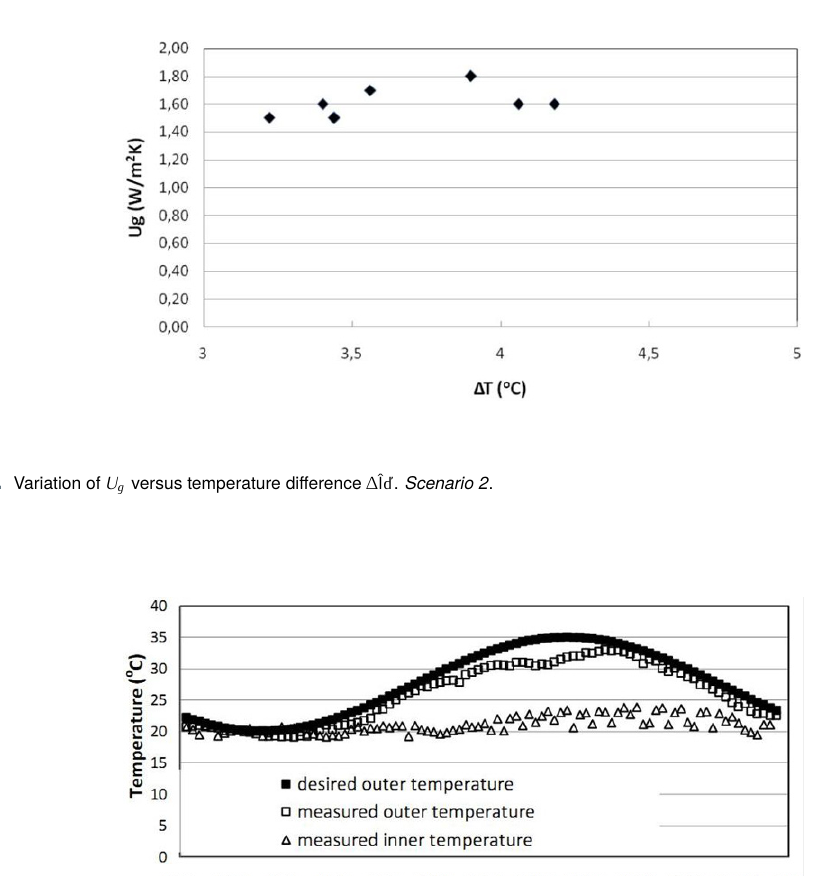
Figure 14. Measured heat flow through the triple glazing. Scenario 2 .